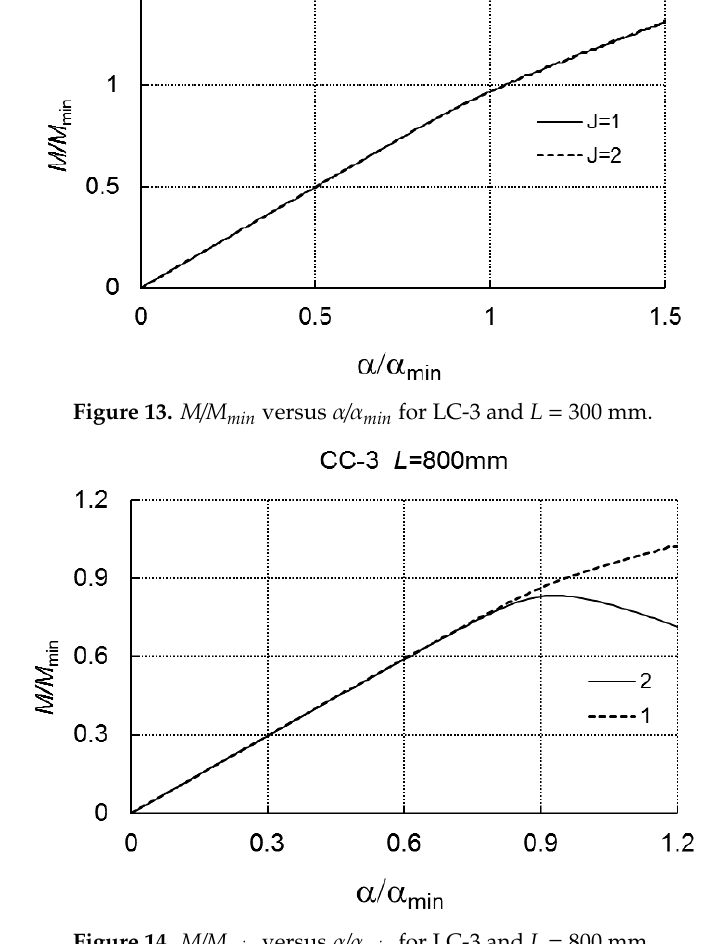
Figure 14 . M/M m in versus α / α min for LC-3 and L = 800 mm.